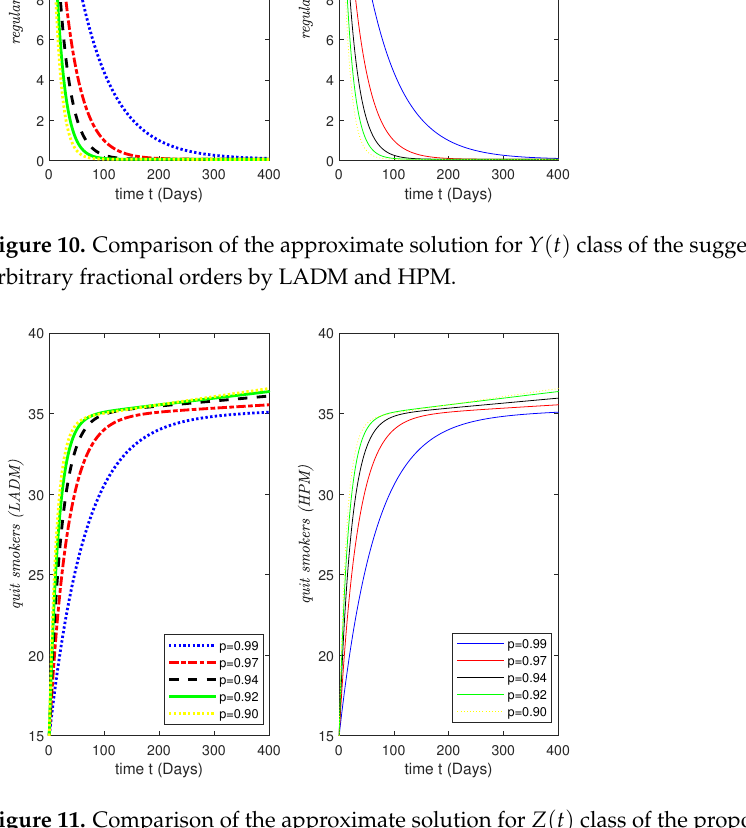
Figure 11. Comparison of the approximate solution for Z ( t ) class of the proposed model at different arbitrary fractional orders by LADM and HPM.